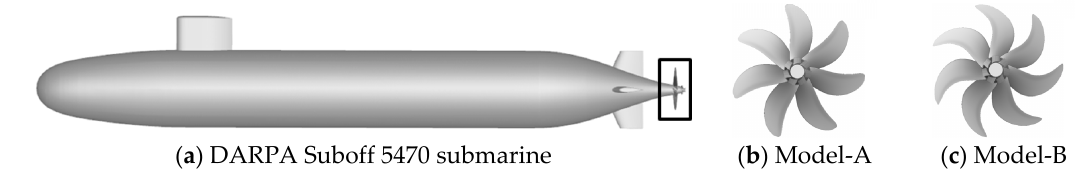
Figure 1. Geometry of the submarine and propeller: ( a ) DARPA Suboff 5470 submarine; ( b ) Model-A; ( c ) Model-B. Table 1. Detailed dimensions of Subo ff body and propeller model.